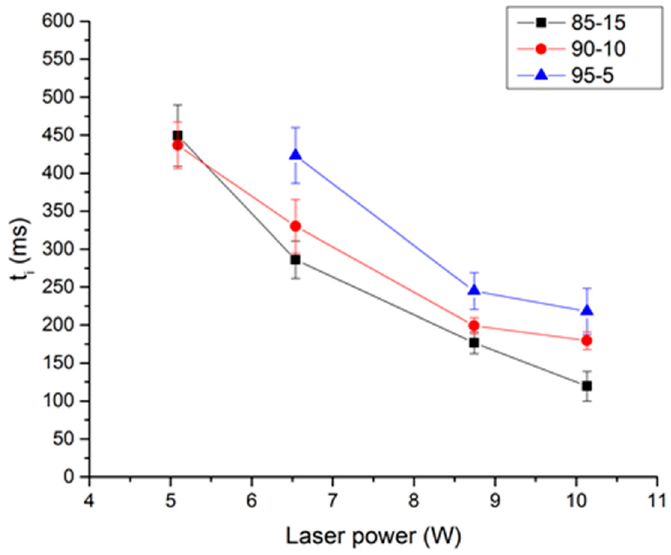
Figure 13. Ignition delay as a function of laser power for the three propellants, P0 = 50 bar of N 2 .